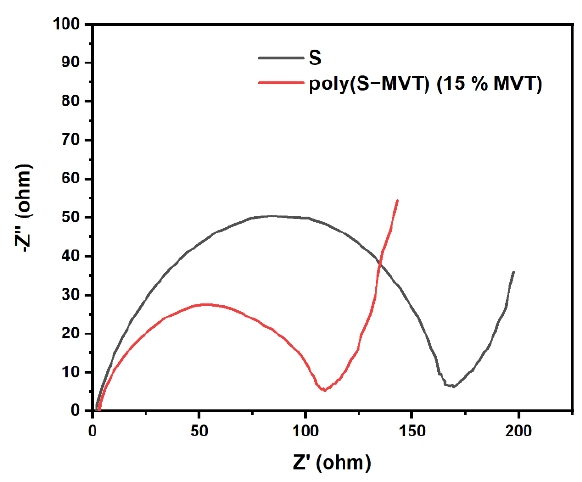
Figure 8. EIS spectra of the fresh S cathode and poly(S-MVT) (15% MVT) cathode.